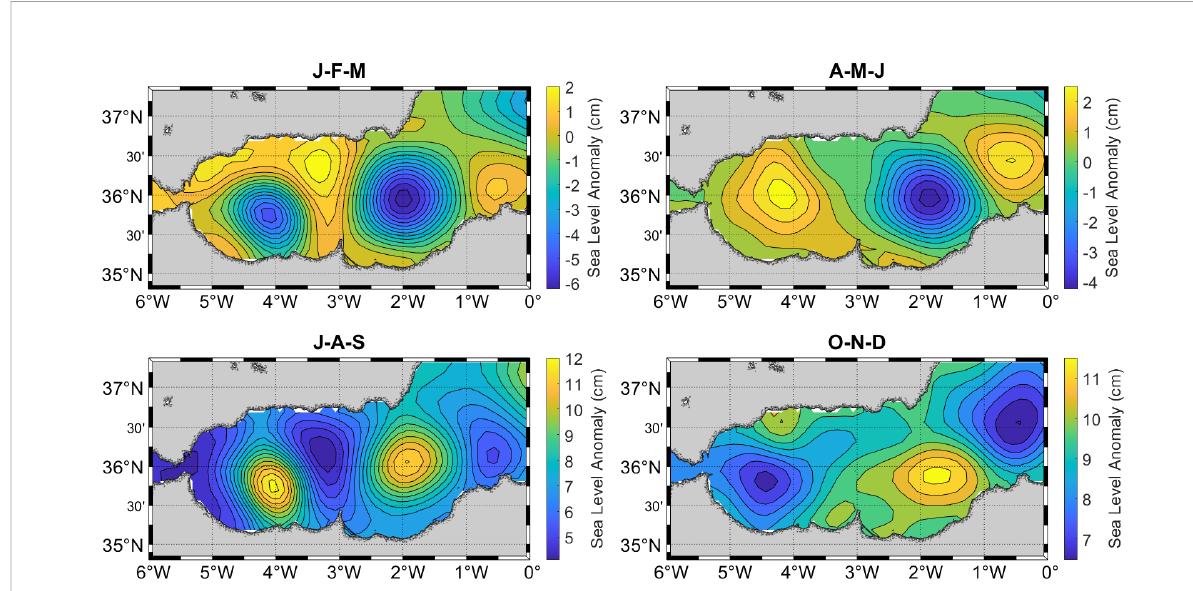
FIGURE 3 Seasonal climatology of Sea Level Anomaly (SLA) in the Alboran Sea (period 1993 – 2021). Isolines are shown every 0.5 cm. J-F-M: January – February – March, A-M-J: April – May – June, J-A-S: July – August – September, O-N-D: October – November – December. CMEMS product: